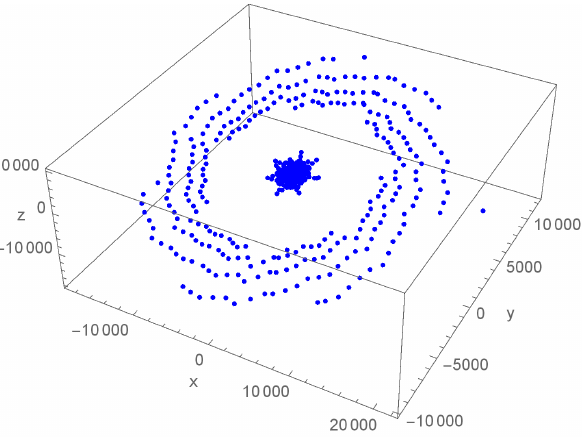
Figure 13. Graph of attractors x n y n z n in 3D for α = 2.5, β = 0.05, γ = 0.7, δ = 0.6, ζ = 3.5, η = 0.05, µ = 0.01, ε = 4.1, υ = 0.09, ρ = 0.02, σ = 0.04, ω = 0.06. with initial conditions x 0 = 0.1, y 0 = 0.02 and z 0 = 0.04.